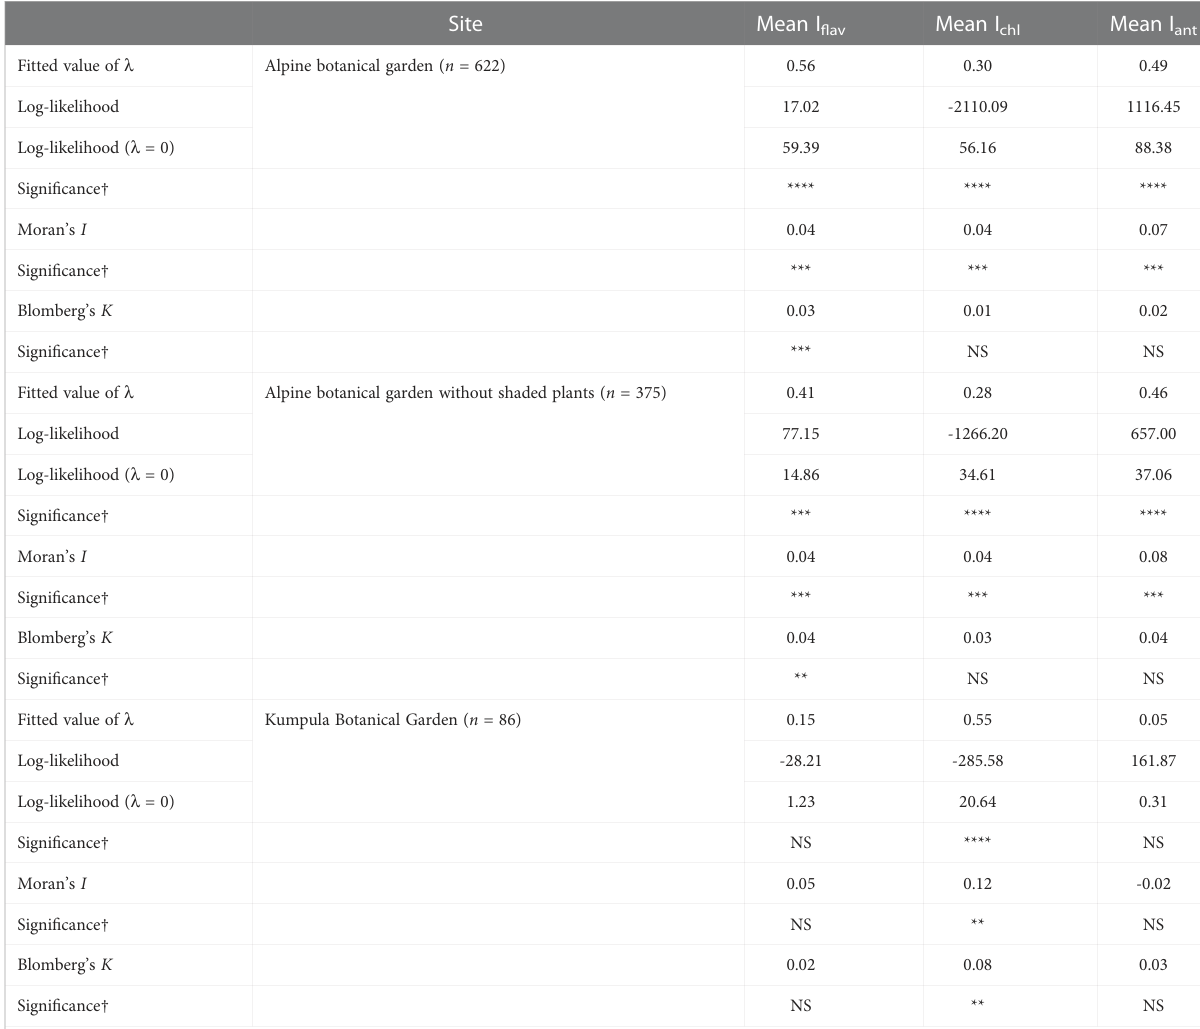
TABLE 1 Phylogenetic signal (Pagel ’ s l ) calculated for a phylogeny based on Jin and Qian (2019) mega-tree and optically measured mean leaf traits (I fl av, I chl and I ant , all with arbitrary